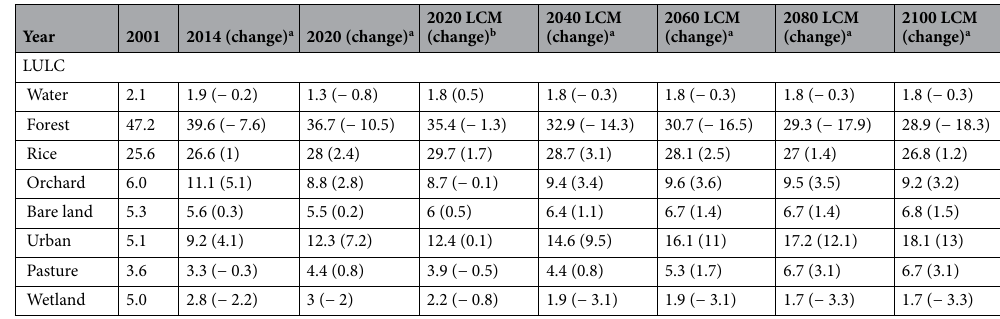
Table 1. Land use land cover (LULC) area percentage of satellite based remote sensing and the projected LULC maps obtained from the Land Change Modeler (LCM). a Change % relative to 2001. b Change % relative to actual map of